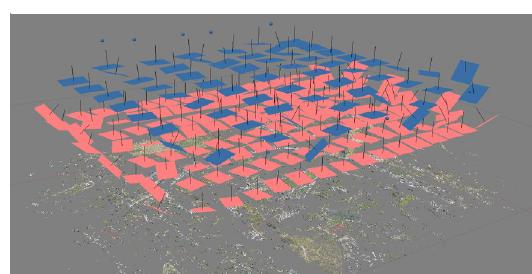
Table 2 Technical data of the